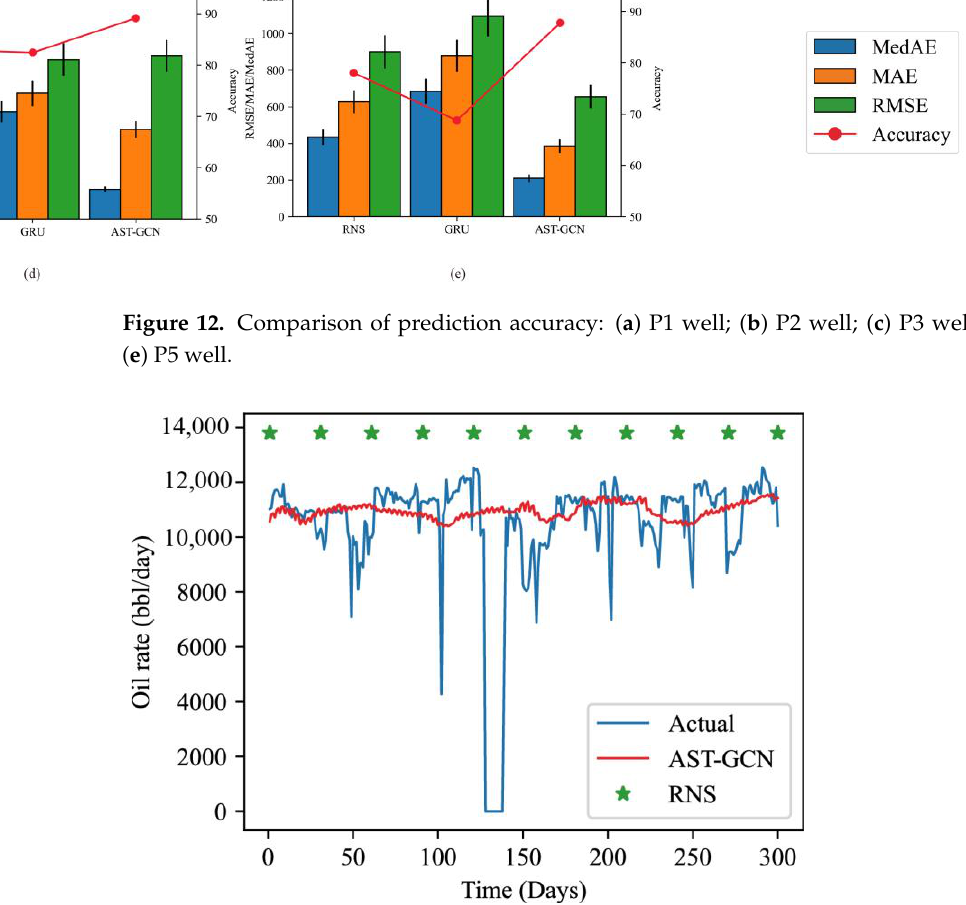
Table 4. Performance comparison of different models for well pattern production forecasting.